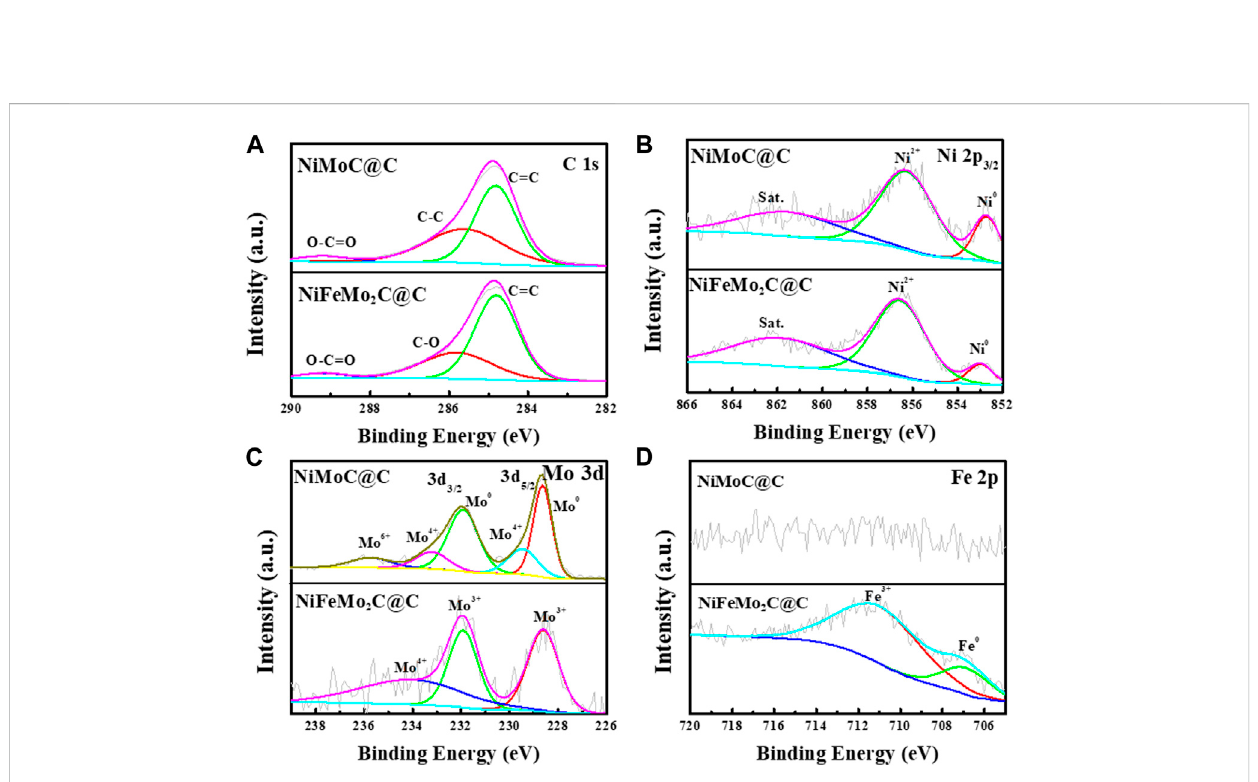
FIGURE 5 (A) High-resolution XPS spectra of C in NiMoC@C and NiFeMo 2 C@C, (B) Ni2p in NiMoC@C and NiFeMo 2 C@C, (C) High-resolution XPS spectra of Mo3d, (D) High-resolution XPS spectra of Fe2p.